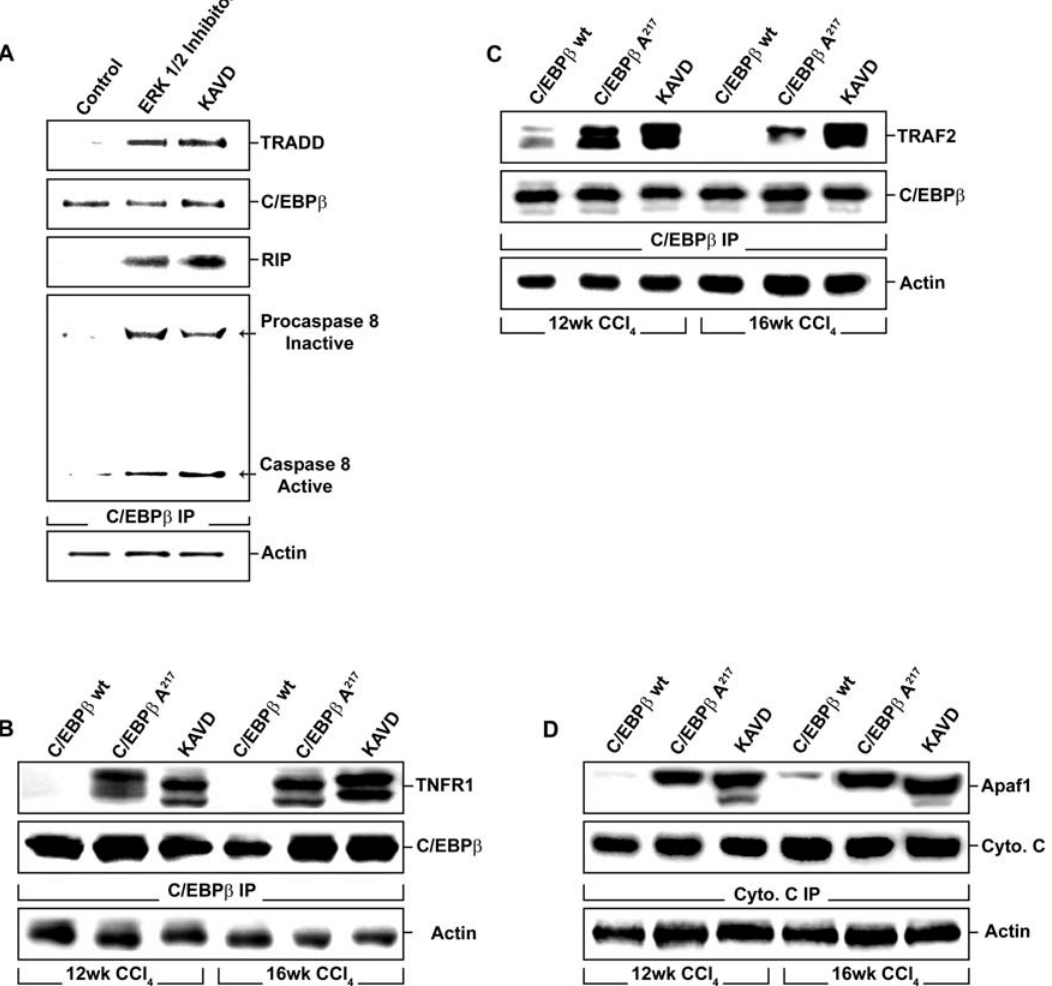
Figure 7. RSK inhibition induces the association of C/EBP b with active caspase 8, TNFR1, TRAF2, TRADD and RIP. A. TRADD, C/EBP b , RIP and caspase 8 immunoblots were performed on C/EBP b immunoprecipitates from primary human HSC treated with an ERK1/2 inhibitor (10 m M) or the cell permeant Ac-KA217VD-CHO peptide (200 m M). Blocking the phosphorylation of C/EBP b by RSK with the ERK1/2 inhibitor or the cell permeant Ac- KA217VD-CHO (KAVD) peptide, increased the association between C/EBP b , active caspase 8, TRADD and RIP. b -Actin was used as an internal control for the immunoprecipitations. B. TNFR1 and C/EBP b immunoblots were performed on C/EBP b immunoprecipitates from HSC isolated from mice treated with CCl 4 for 12 or 16 weeks as described in Materials and Methods. Blocking the phosphorylation of C/EBP b by RSK with C/EBP b